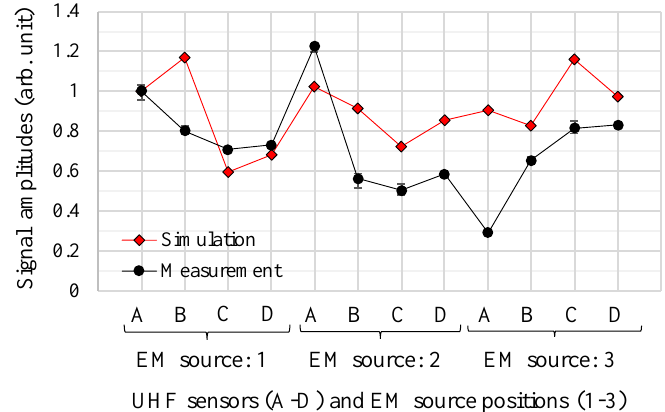
Figure 15. Simulated and measured signal amplitudes for each UHF sensors and EM wave source.